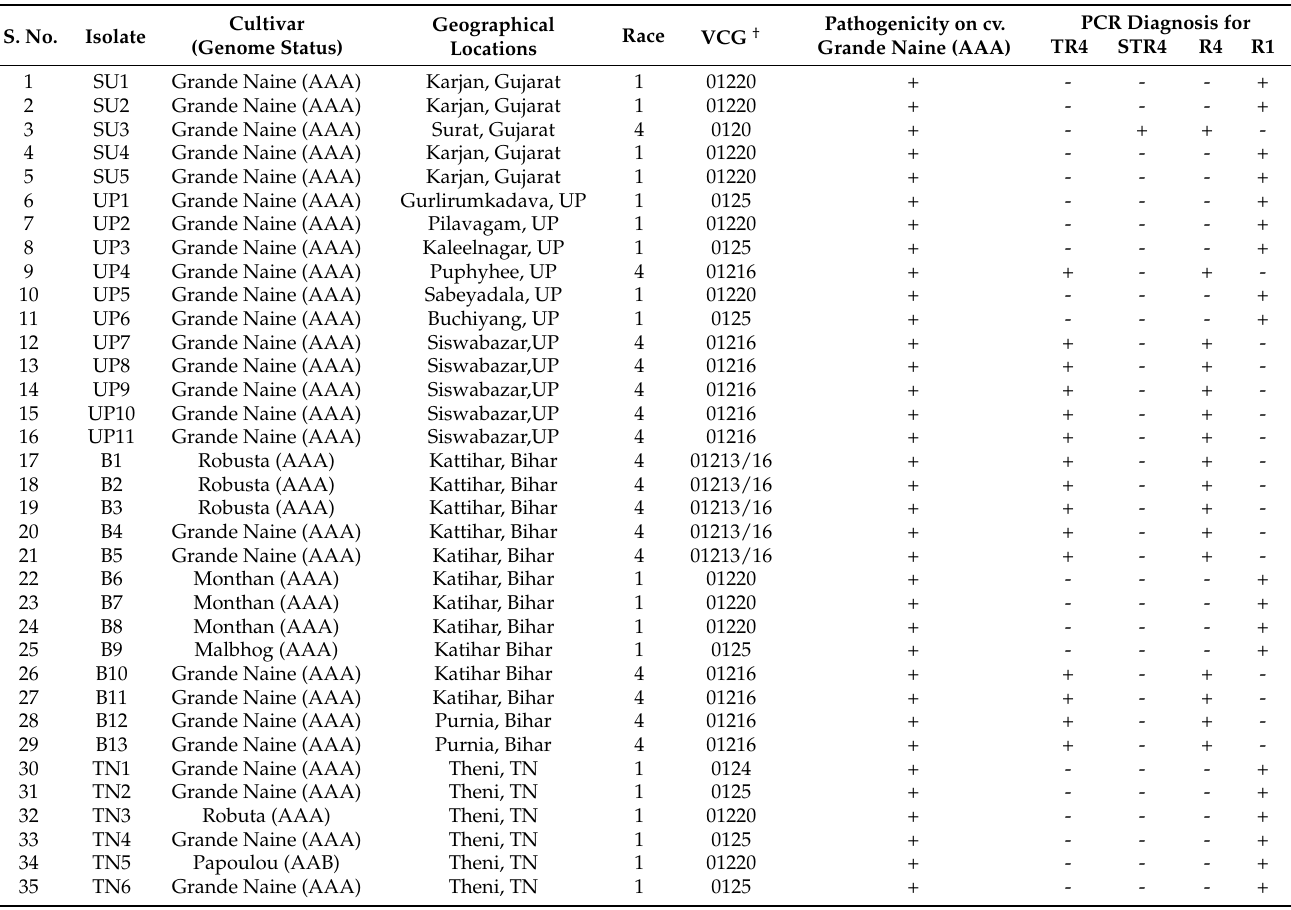
Table 1. Details of Foc isolates used in the study, code, host genome, geographical origin, and their race/vegetative compatibility group (VCG) characterization and pathogenicity on the cv. Grande